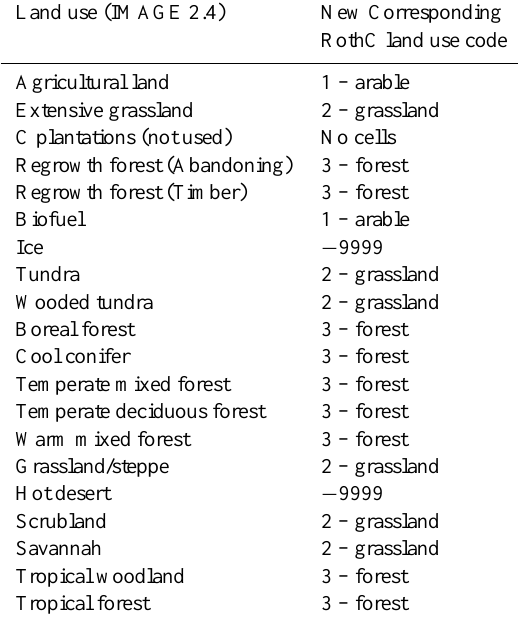
Table 3. Classification of IMAGE land use types into RothC land cover classes. “ − 9999” denotes areas which were not